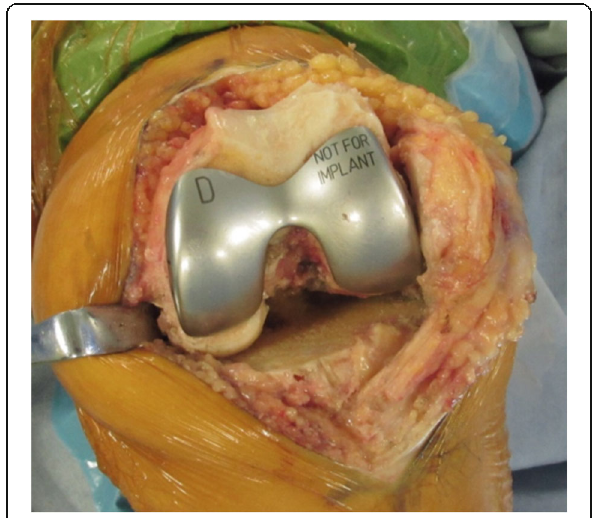
Fig. 2 Intraoperative gap measurement without the trial component (left) and with the trial component